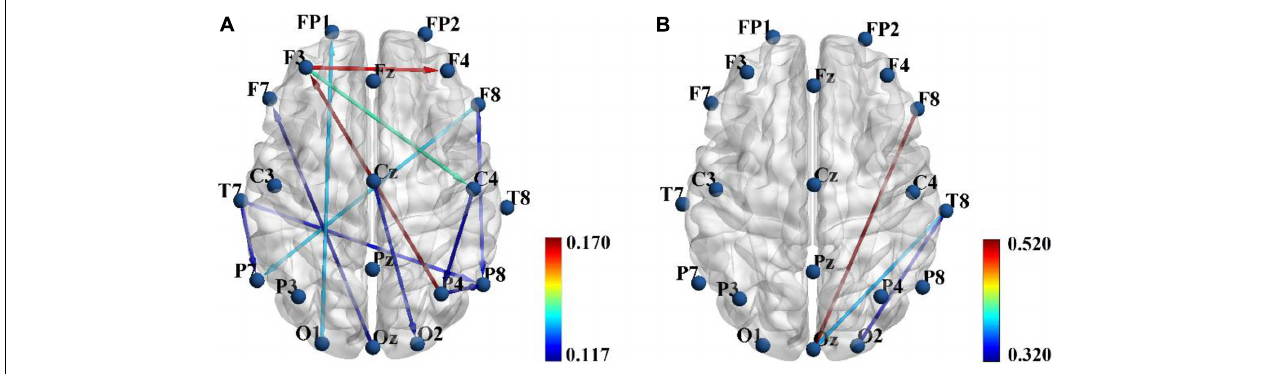
FIGURE 3 | The spatial distribution of the 12 partial directed coherence (PDC) (A) and three phase lag index (PLI) (B) connectivity features selected from the combined feature set when the classification performance was optimal. Color bar represents the discriminative power i.e., Fisher score.